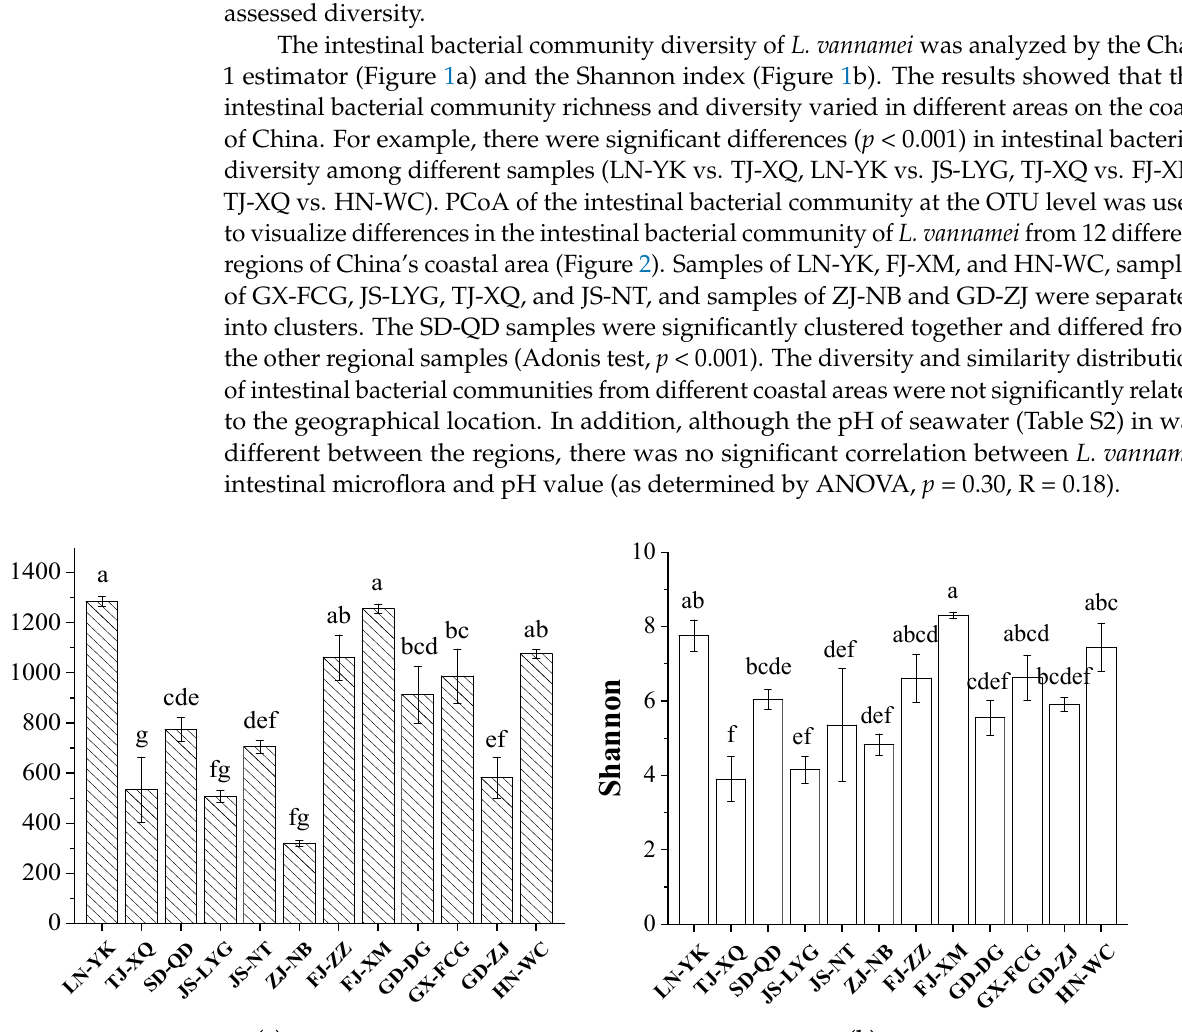
Figure 2. Beta diversity (PCoA of the intestinal bacterial community at the OTU level) of intestinal bacteria among different samples. 3.2. Composition of the Intestinal Bacterial Community of L. vannamei from Different Regions 3.2.1. Composition of the Gut Microbiota High-throughput sequencing showed that the intestinal bacterial community com- position and structure at the phylum level varied from region to region (Figure S2). The changes and differences in the relative abundances of Proteobacteria , Bacteroidetes , Teneri- cutes , Firmicutes, and Actinobacteria were the most significant among different areas. The dominant phyla in the intestine of L. vannamei shrimp from different regions also showed differences. For example, Tenericutes was the dominant phylum in JS-NT and JS-LYG (35.4–38.1%); Firmicutes was the dominant phylum in TJ-XQ and JS-LYG (38.0–53.4%), and Actinobacteria was the dominant phylum in SD-QD (31.9%). At the family level, the composition of the intestinal bacteria varied more apparently among regions (Figure 3a). As shown by the heat map of the top 50 abundant families in